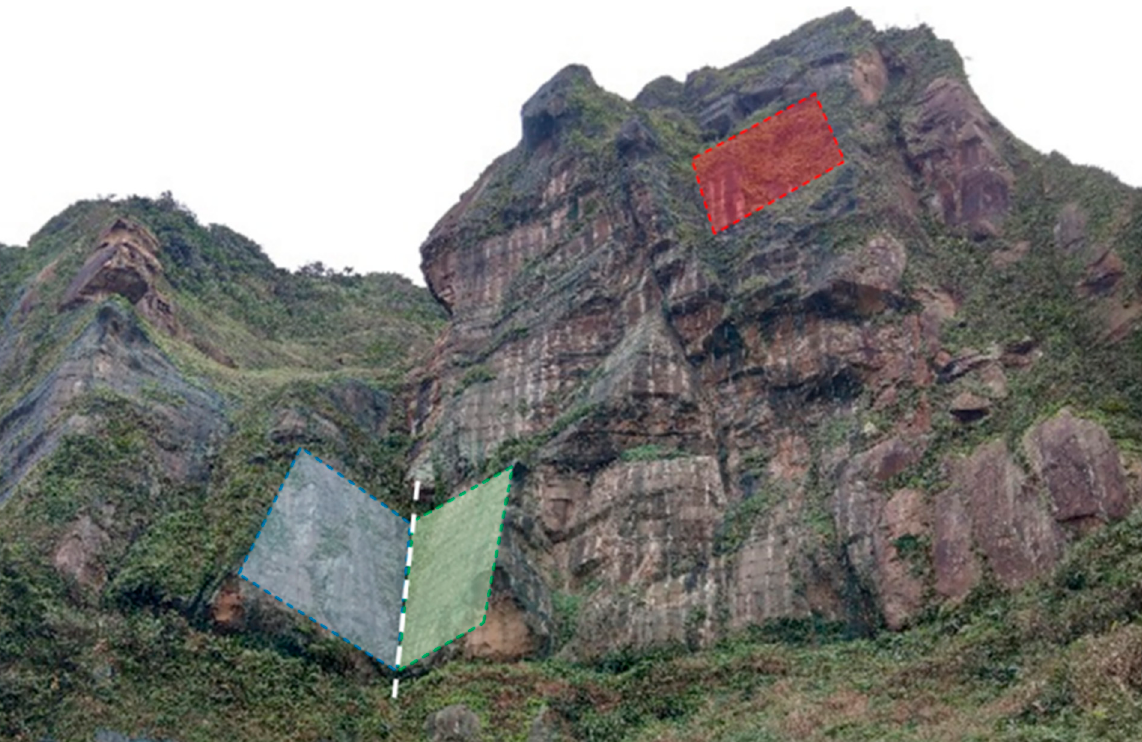
Figure 2. Wedge failure characteristics on the slope at 81.8 km of Provincial Highway No. 2. Red, green and blue frames means joint plane 1, 2 and 3 respectively.